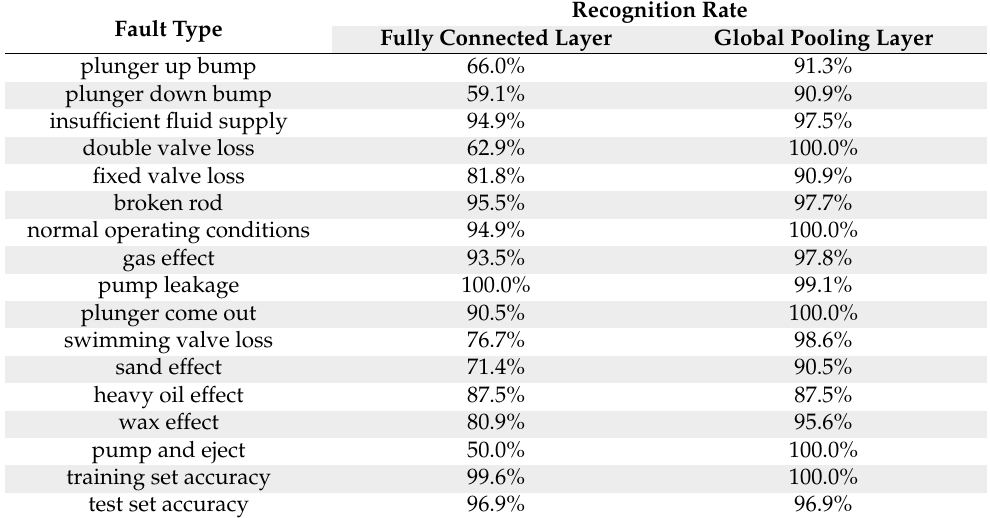
Table 2. Single fault type and overall recognition